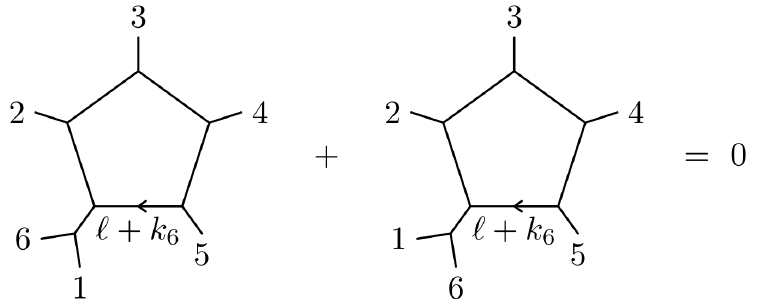
Figure 3 . The antisymmetry of the 61 -pentagon from the integrand A (1 , 2 , 3 , 4 , 5 , 6; ‘ ) . The momentum running into the 61 external tree in the graph on the right is ‘ + k 6 because in the color ordering 1 , 2 , 3 , 4 , 5 , 6 a momentum ‘ must run between 6 and 1 . Therefore in order to preserve the momentum assignment in the edges between the two cubic graphs, the pentagon on the left is part of the integrand A (1 , 6 , 2 , 3 , 4 , 5; ‘ + k 6 ) with momentum ‘ + k 6 running between legs 5 and 1 as dictated by the convention (2.24). Therefore to extract this pentagon the field-theory rules of section 2.3 must be used with a 6 = 1